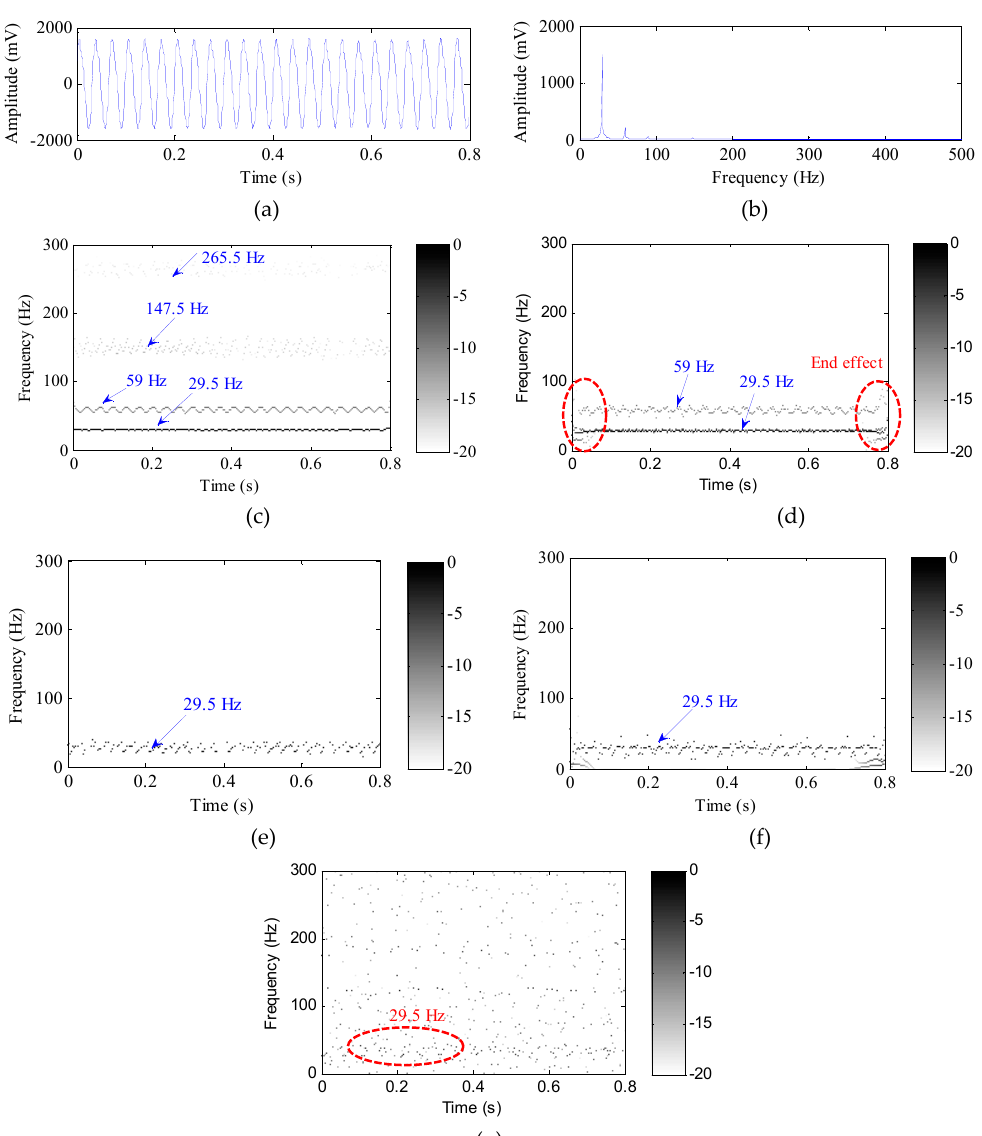
Figure 18. The analyzed results of the rotor rub-impact signal: ( a ) Temporal waveform, ( b ) FFT spectrum, time-frequency representations obtained by ( c ) IAVMD, ( d ) OVMD, ( e ) LMD, ( f ) EMD, and ( g ) WT.